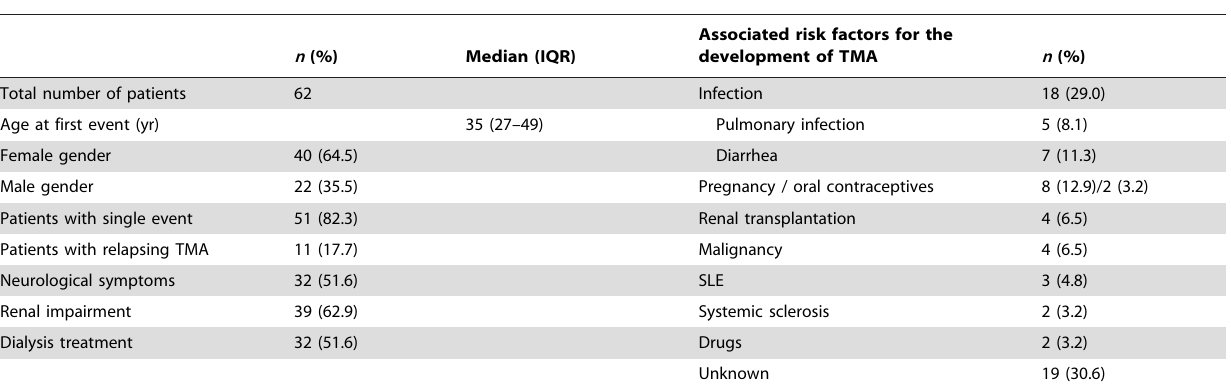
Table 1. Clinical characteristics of patients on admission.